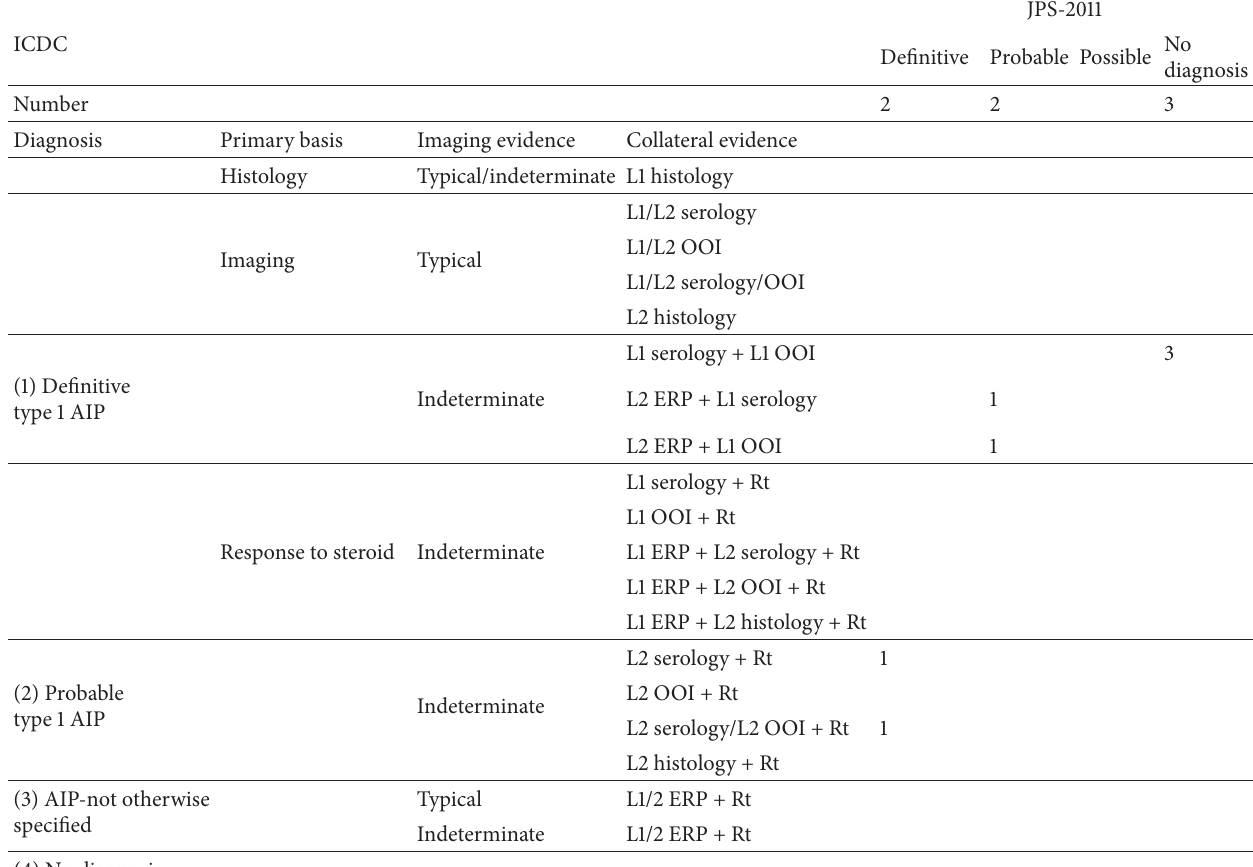
Table 6: Comparison of diagnostic abilities of the ICDC and JPS-2011 related to mismatched